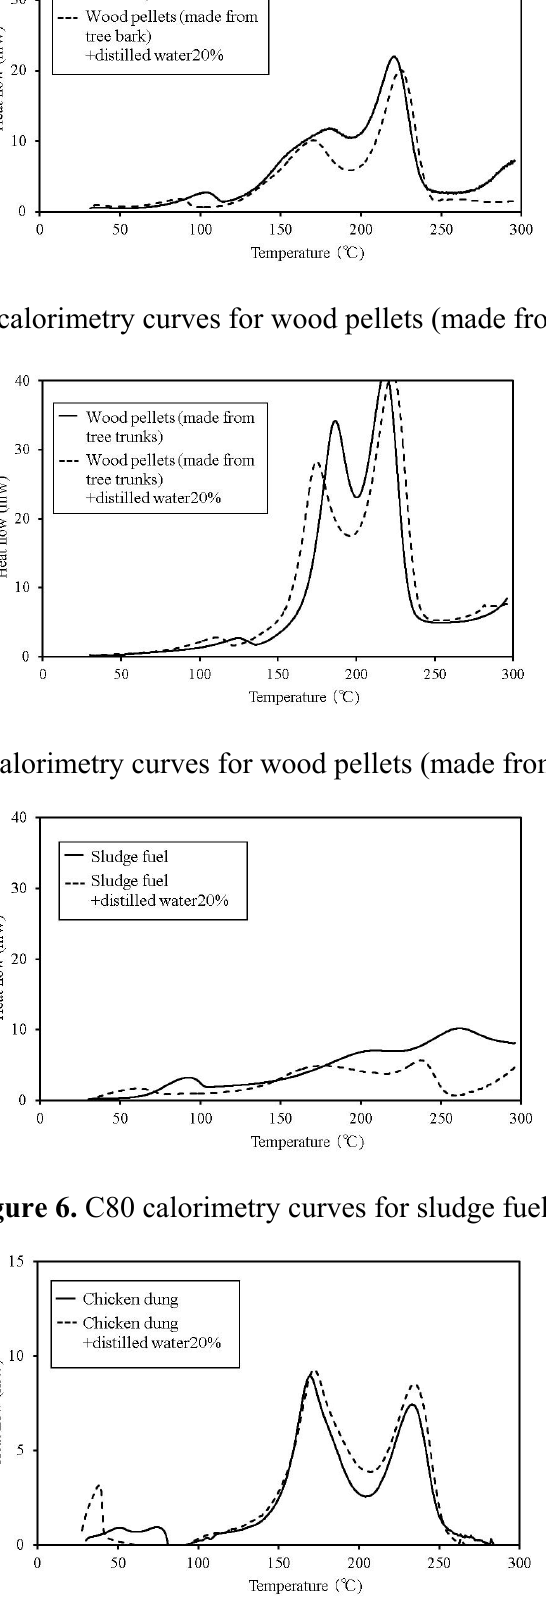
Figure 7. C80 calorimetry curves for chicken